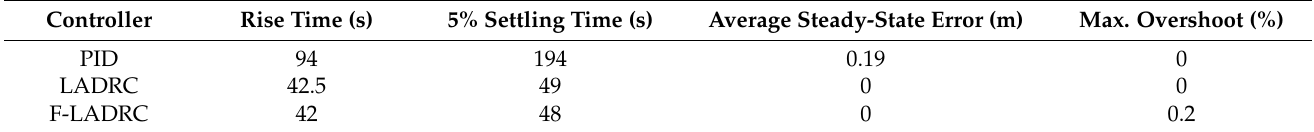
Figure 9. Control response curves of the AUV system with sine disturbance force. ( a ) Depth response curves of different controllers. ( b ) Magnified view of depth response curves. Table 7. Characteristic parameter comparison for the response curves in Figure 8.